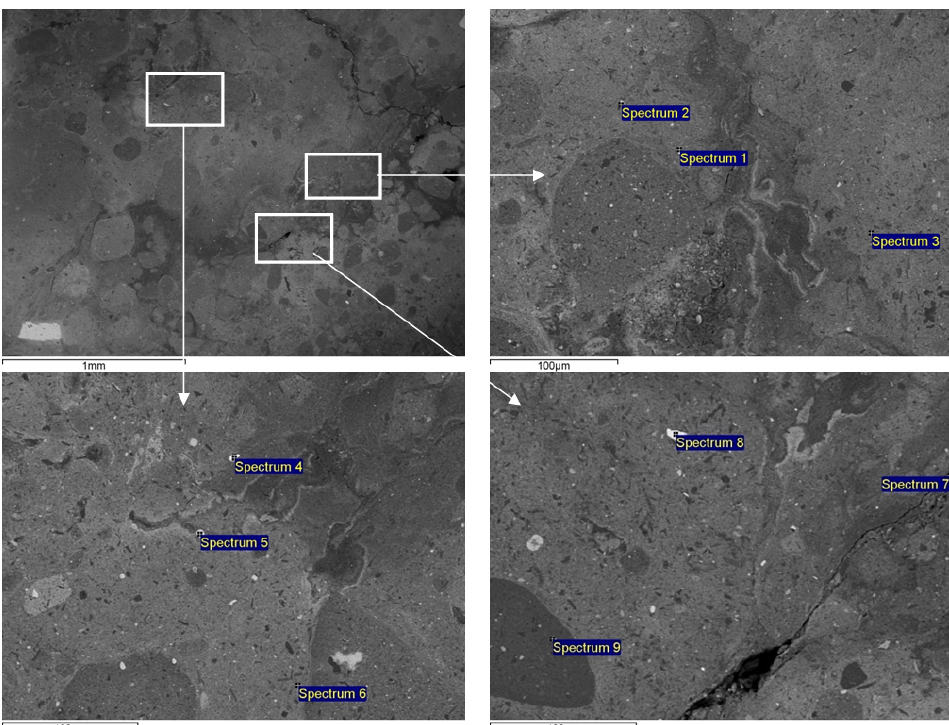
Figure 12. Bauxite occurrence Crvena glavica. Analysed field 3—sample 243, with details and analysed points. Spectrum 1—Xenotime; Spectrum 2, 5—Hematite + Al–hidroksid; Spectrum 3— Clay + Fe–hydroxides; Spectrum 4—Monazite; Spectrum 6–9—Zircon.